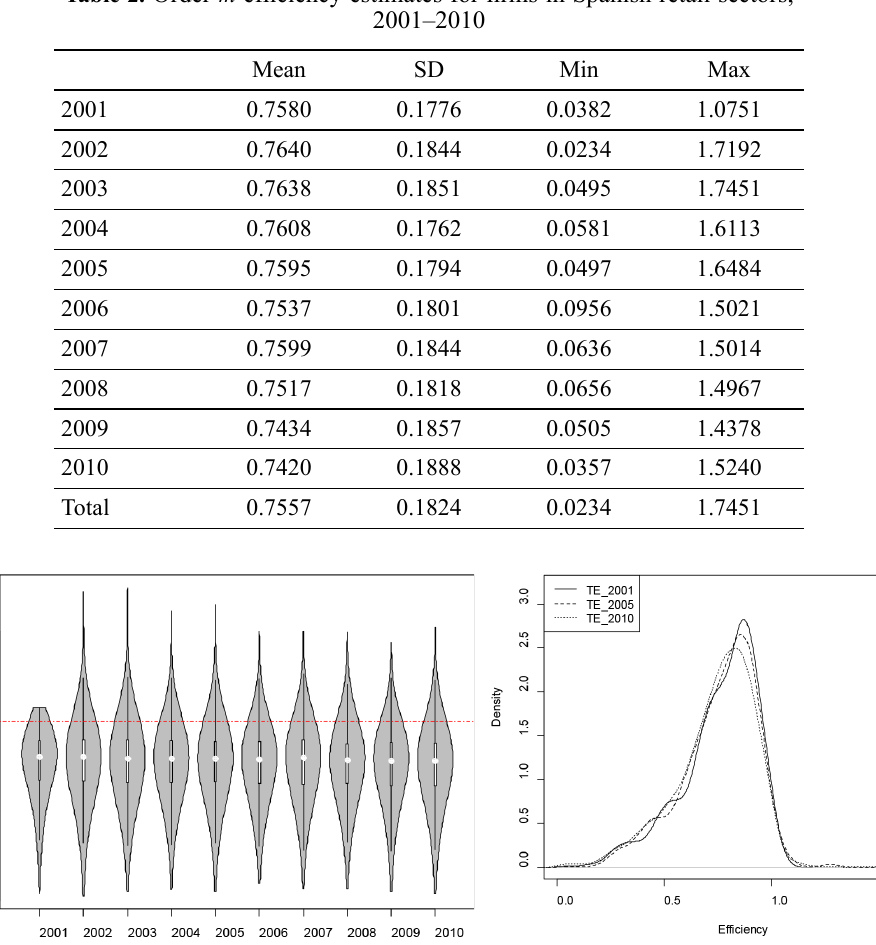
Table 2. Order- m efficiency estimates for firms in Spanish retail sectors,